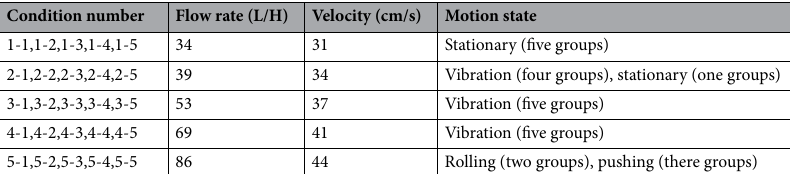
Table 1. Test groups and test